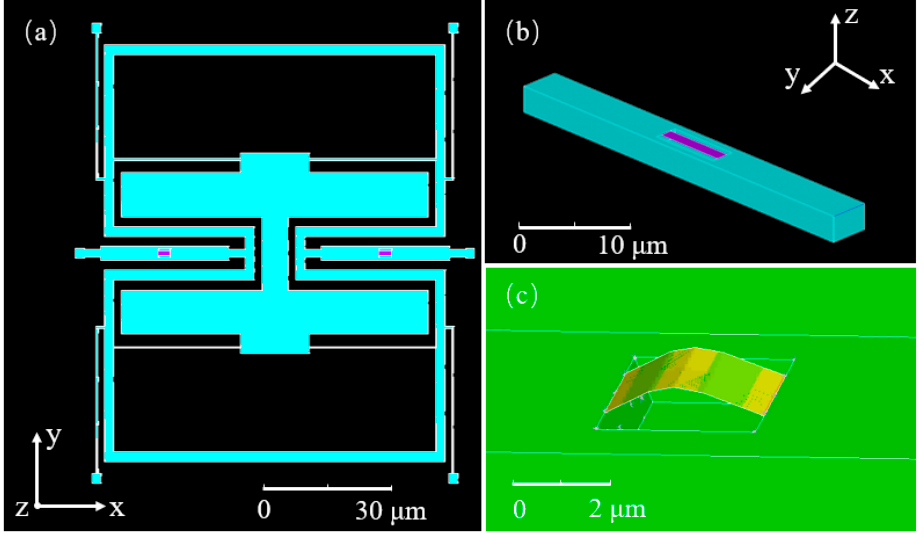
Figure 6. Finite element simulation model of graphene resonant gyroscope and graphene resonant beam: ( a ) the driving mode of the graphene resonant gyroscope; ( b ) double-clamped graphene beam supported on a Si substrate; ( c ) the detecting mode of graphene resonator gyroscope.